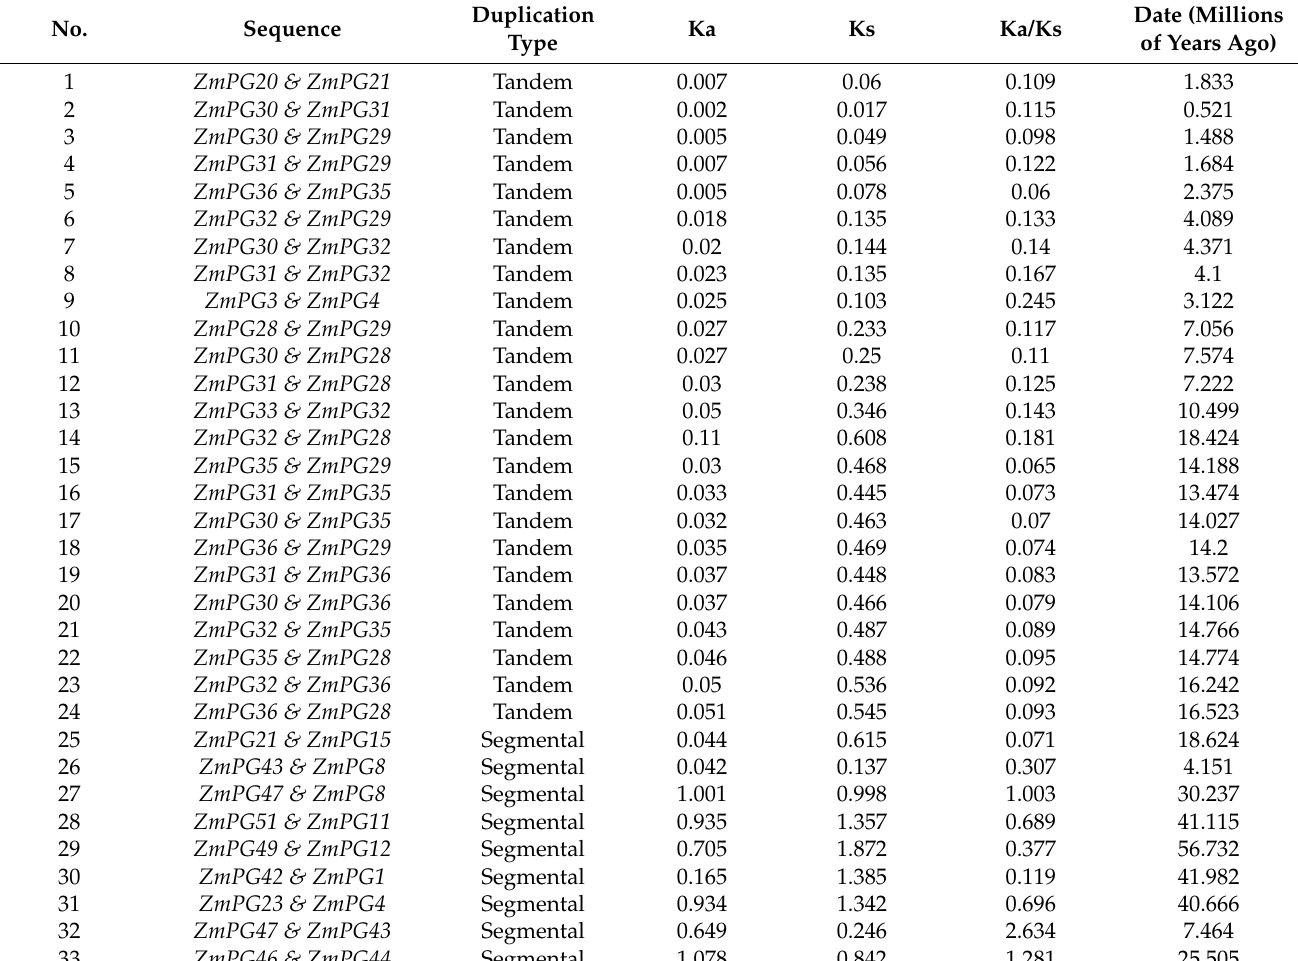
Table 2. The duplication events of ZmPGs identified in